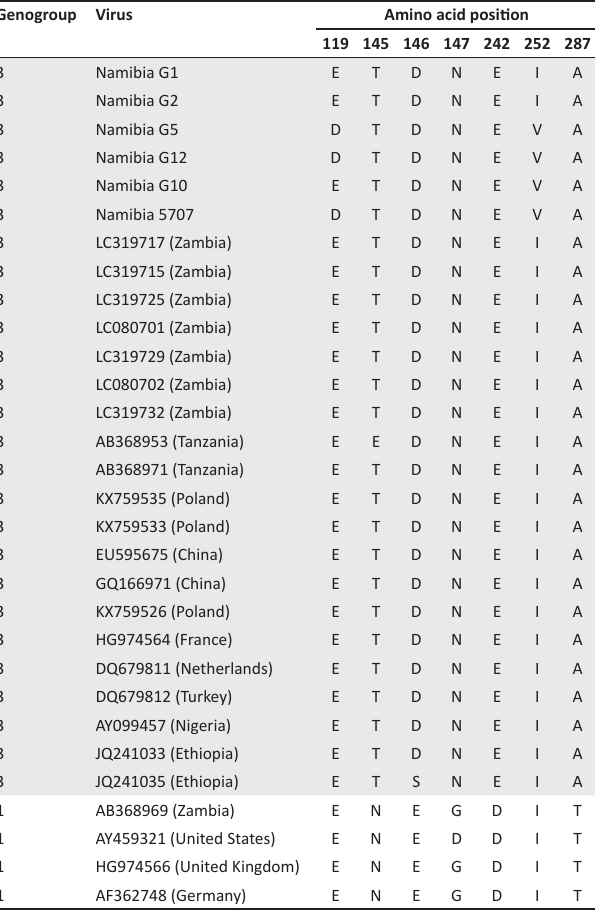
TABLE 3: Comparison of amino acid residues of the VP1 between the samples investigated and other infectious bursal disease viruses. Genogroup Virus